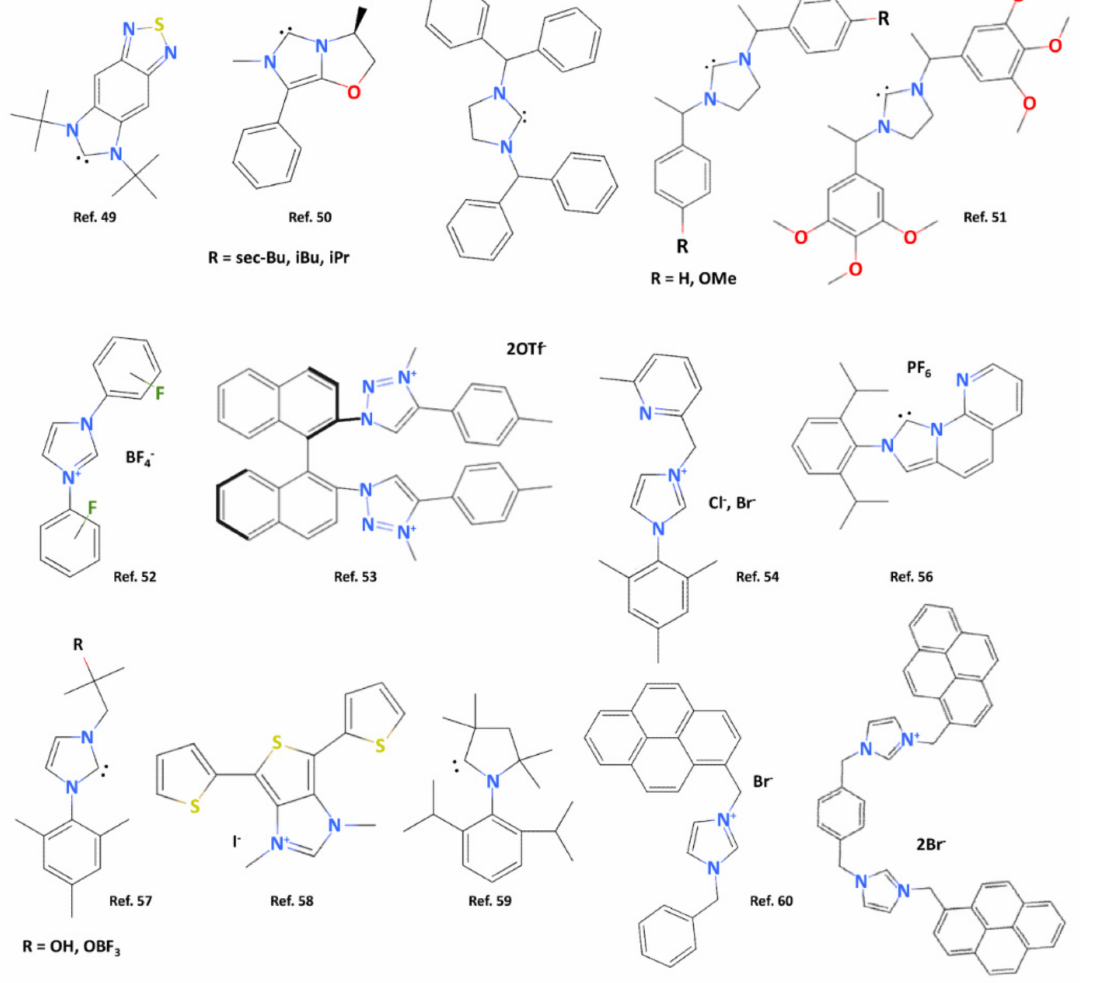
Figure 2. Molecular structures of some NHCs in recent